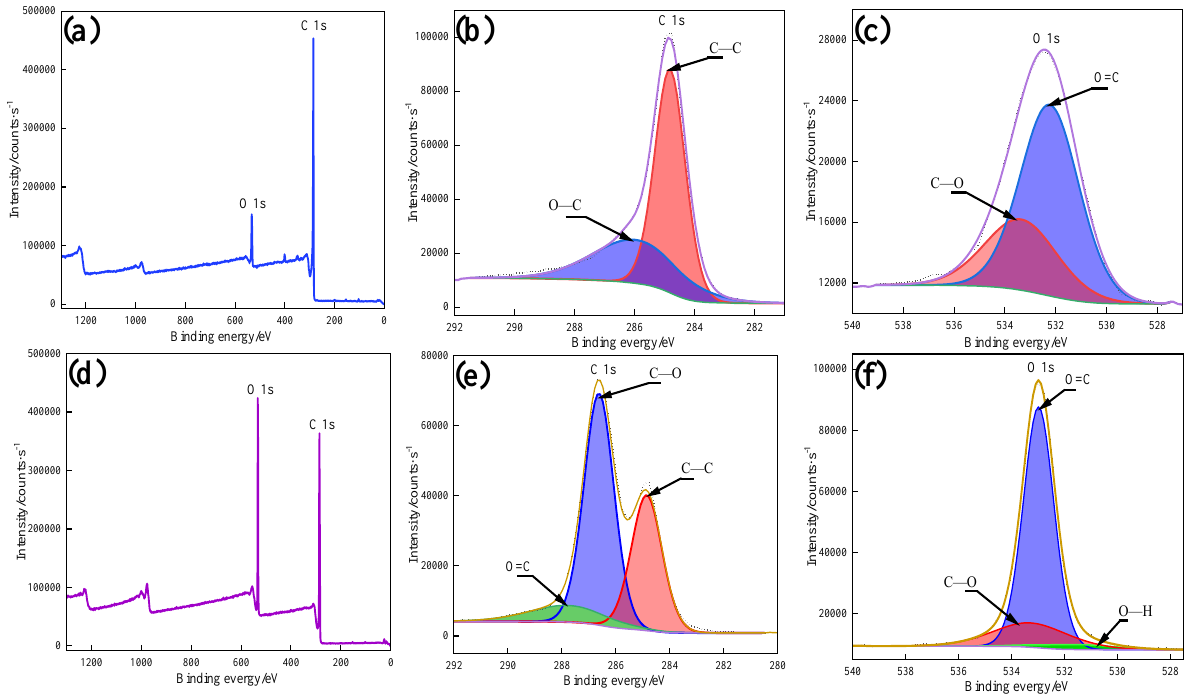
Figure 5. XPS spectrogram of ( a ) and ( d ) full spectra, ( b ) and ( e ) C1s spectra, ( c ) and ( f ) O1s spectra for 8CP and 8CPP, respectively.